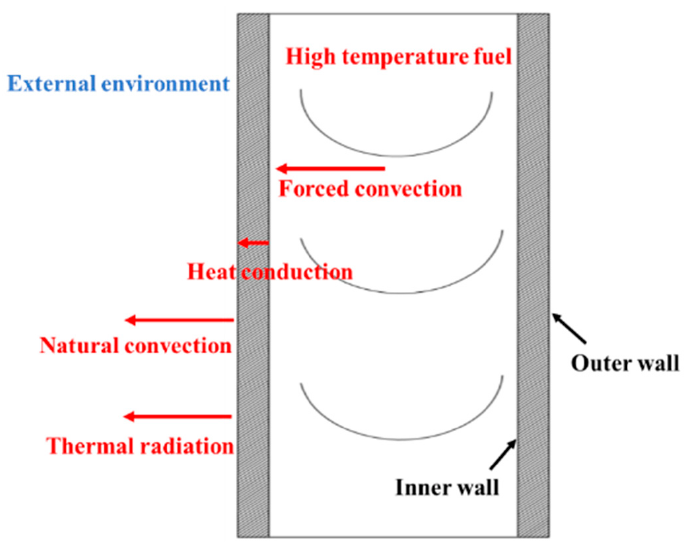
Figure 8. Diagram of the fuel heat transfer process at the nozzle of the CR injector.